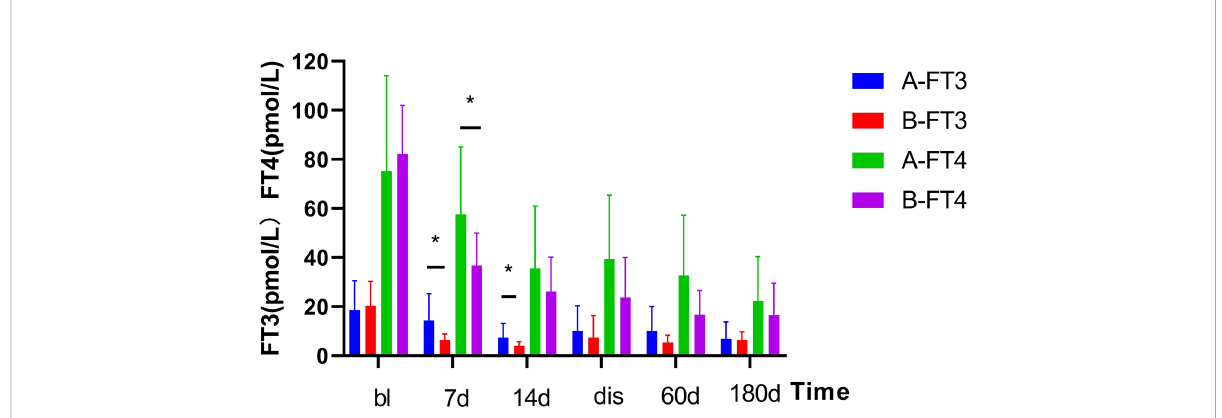
FIGURE 1 Changes in serum thyroid hormone levels before and after treatment in two Groups. After treatment, the serum thyroid hormone decreased signi fi cantly. Results are presented as the mean value ± standard deviation. *Statistically signi fi cant difference between the two groups ( p <0.05). bl, baseline; dis, discharge; FT3, triiodothyronine; FT4, free